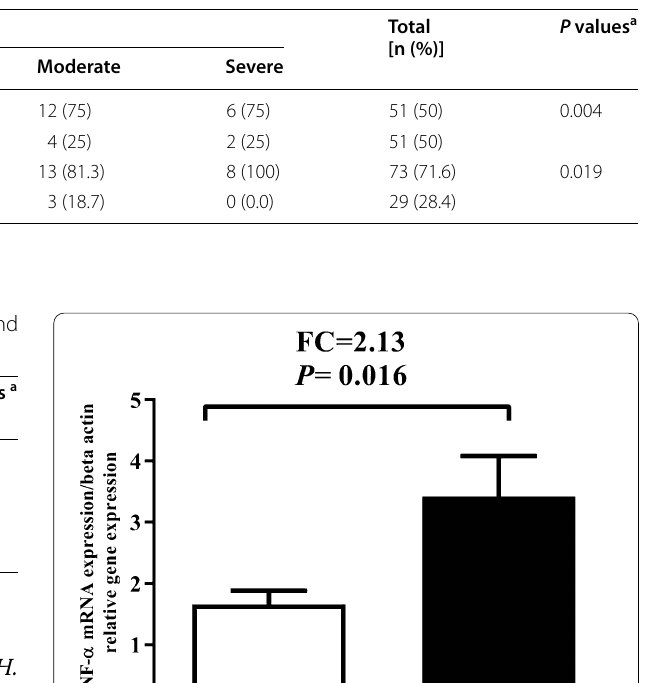
Table 1 Association between score of acute inflammatory with the oipA and cagA virulence factors in infected patients